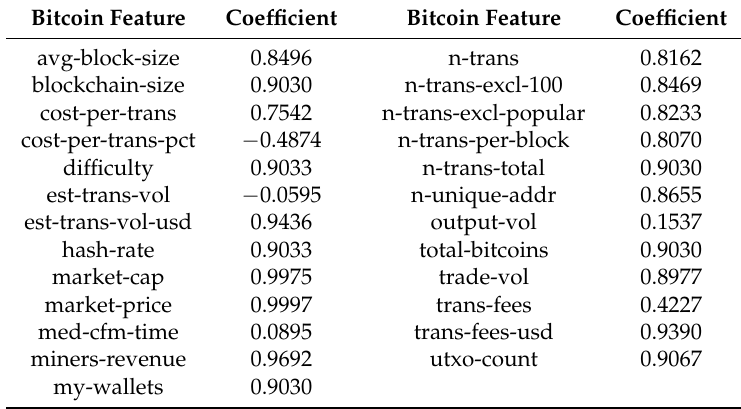
Table 2. Spearman correlation coefficients between the Bitcoin price and various